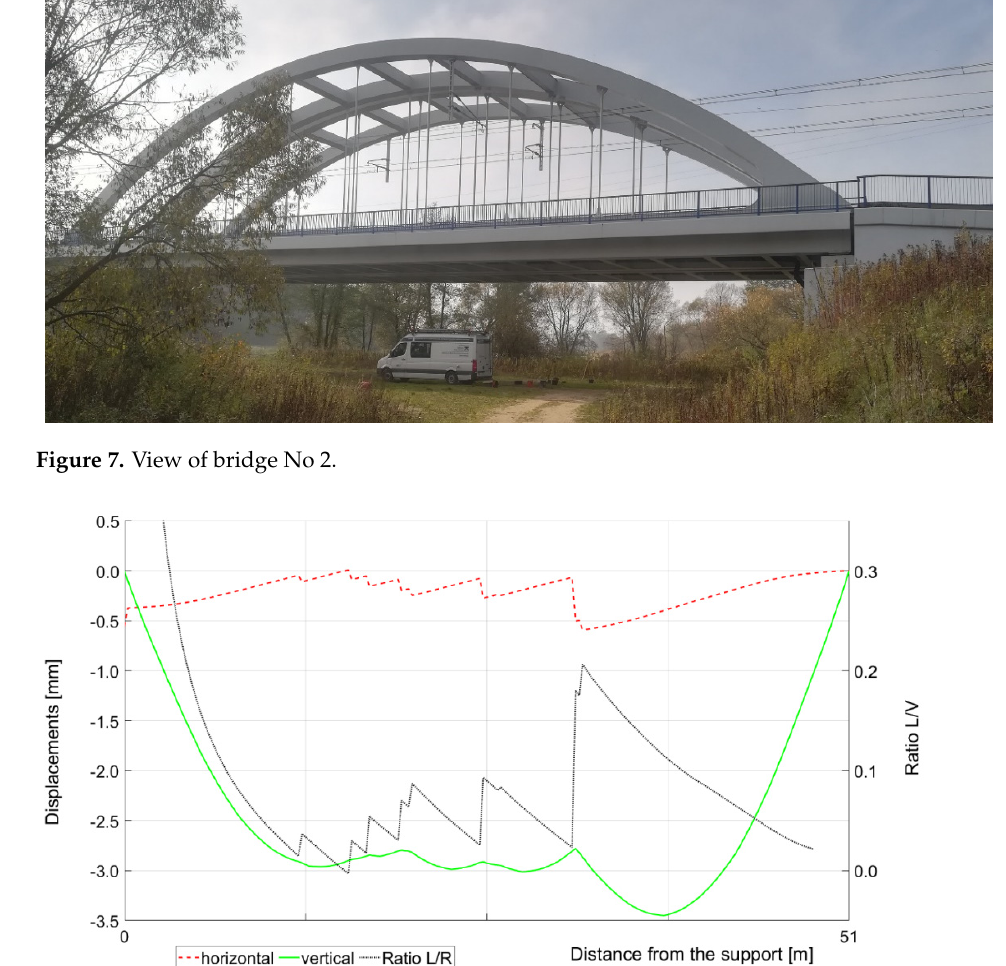
Figure 8. Results of calculation for passage of multiple-unit passenger train: left axis—the calculated extremal vertical and simultaneous horizontal displacement along the span; right axis—ratio L/V.